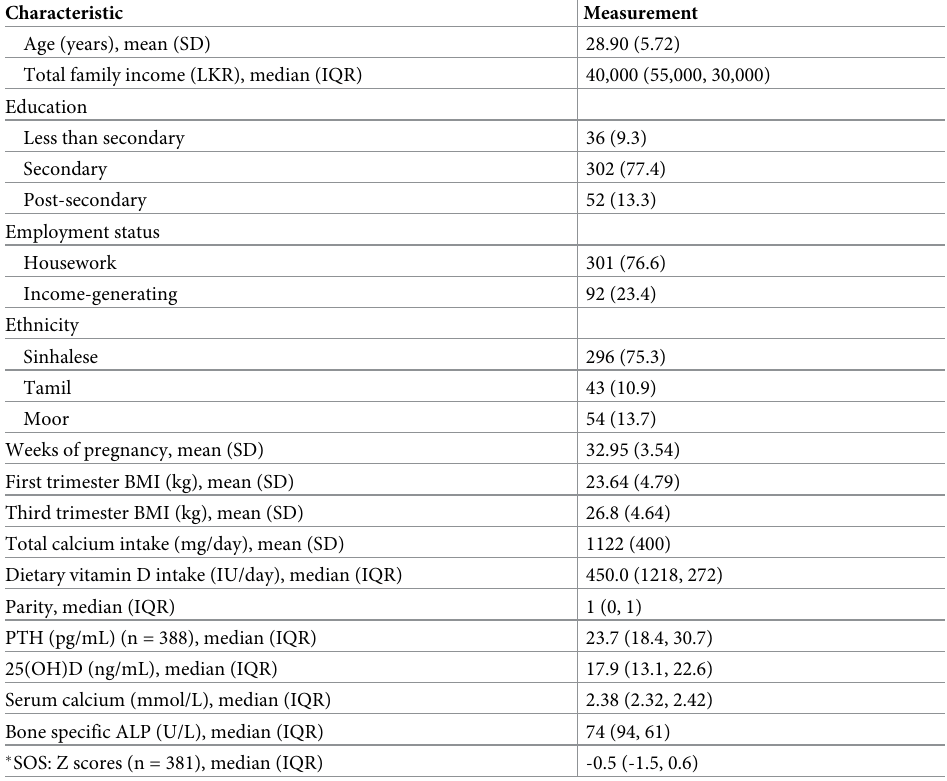
Table 1. Baseline characteristics of the study sample (n =